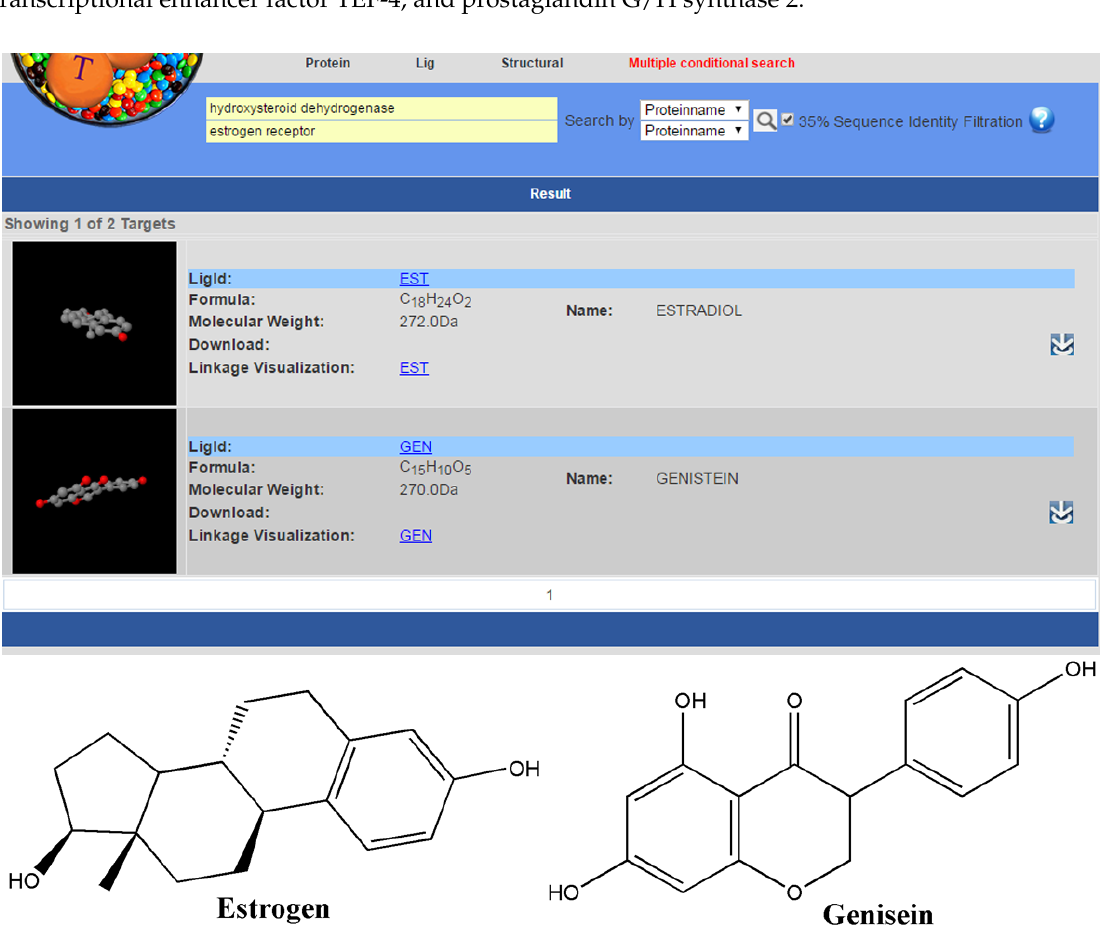
Figure 3. The multiple conditional search in MTLD.